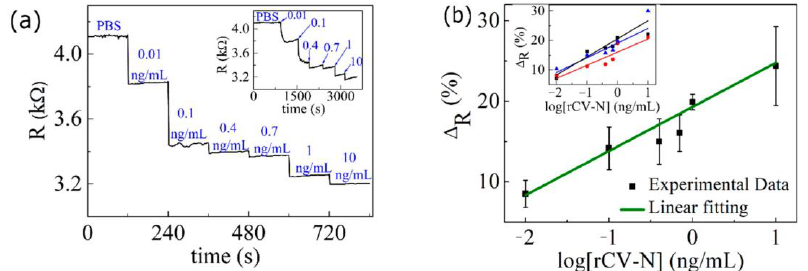
Figure 6. ( a ) Resistance versus time of a graphene-ISFET in contact with solutions with different concentrations of rCV-N. Each plateau corresponds to the last two minutes before a concentration change. The inset shows real time measurement of the electrical resistance for the same concentrations. ( b ) Average of the percentage change in resistance for three devices (shown in the inset) versus log[RCV-N]. The lines are linear fits to the data.